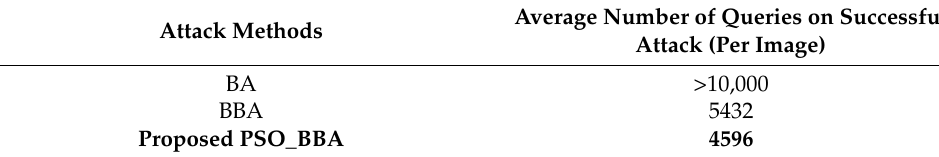
Table 2. Comparison of the average query